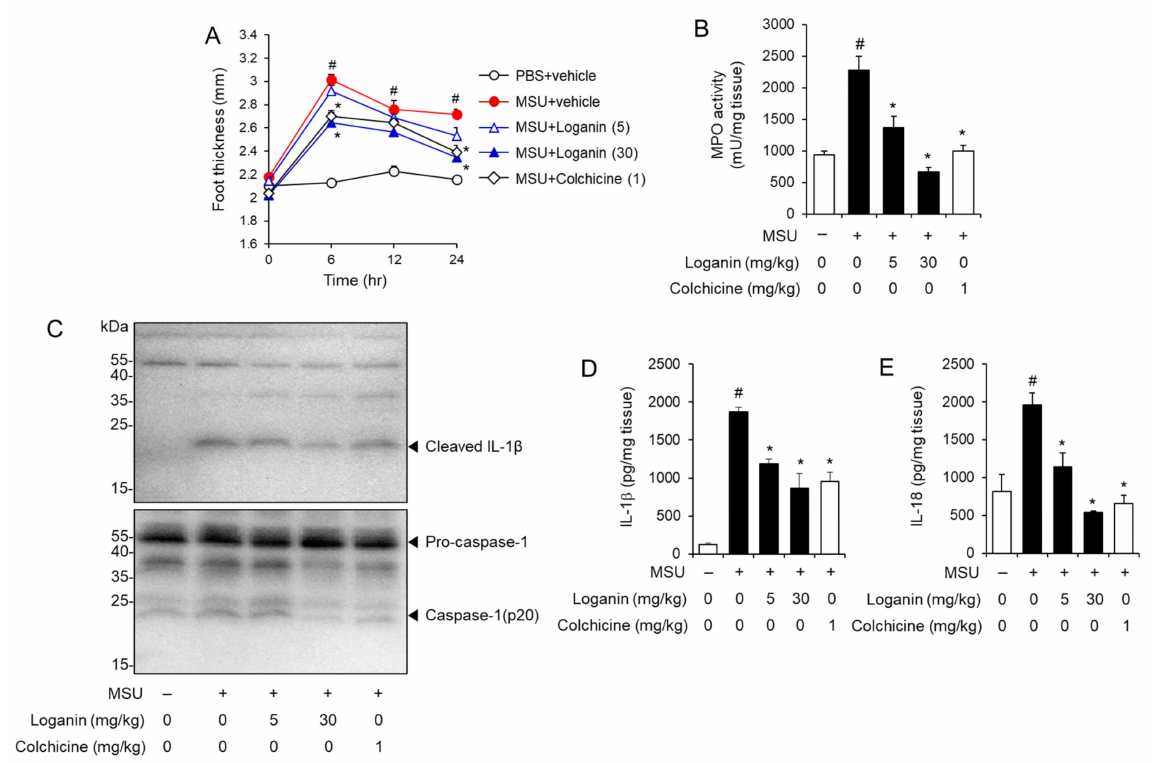
Figure 3. Oral administration of loganin alleviates MSU crystals-induced inflammatory symptoms and NLRP3 inflam- masome activation in a mouse acute gout model. Mice were orally administered loganin (5 or 30 mg/kg) or colchicine (1 mg/kg). After 1 h, MSU crystals (2 mg/0.1 mL of PBS/mouse) or PBS alone were subcutaneously injected into the hind footpad of each mouse. After 24 h, the foot tissues were collected for analysis. ( A ) Time course of foot thickness changes. ( B ) MPO activity in the foot tissues was analyzed for neutrophil infiltration. ( C ) Immunoblotting of foot tissues for pro-caspase-1, caspase-1 (p20), and IL-1 β expression. ( D , E ) ELISA for IL-1 β and IL-18 expression in foot tissues. The values in ( A , B , D , E ) represent the means ± SEM ( n = 5 mice); # significantly different from vehicle alone, p < 0.05; * significantly different from MSU alone, p <